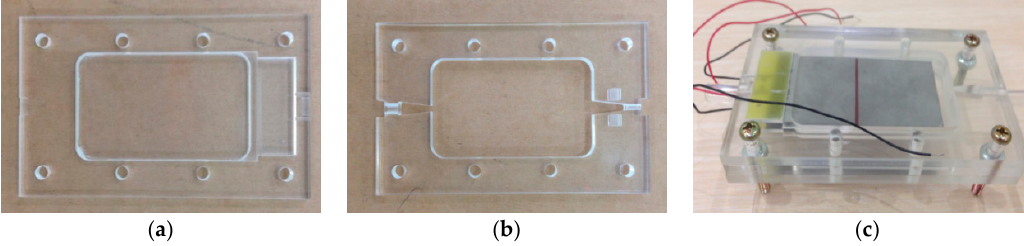
Figure 3. Photographic images of pumping element: ( a ) outer cover, ( b ) middle chamber, and ( c ) assembled unit. Table 1. Material properties of piezoelectric bimorph.